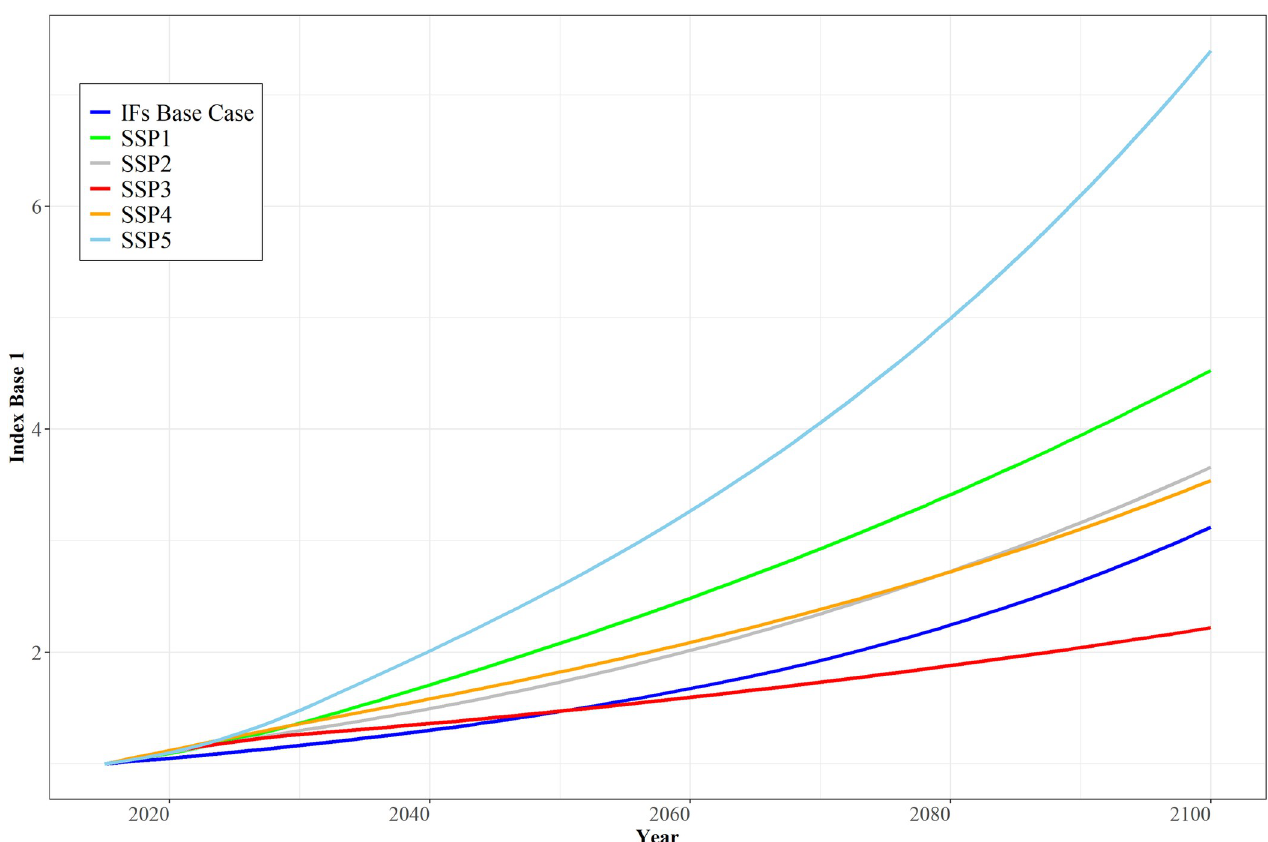
Fig 3. Global TFP projections from the OECD across SSPs and the Base Case projection from IFs. Notes: TFP scaling in the two sources differs and has been indexed to 1 to facilitate comparison. Country aggregation uses simple averages rather than GDP-weighting. SSPs 2 and 4 and the IFs Base Case are so close that the lines nearly overlap. Source: OECD projections courtesy of Rob Dellink and Jean Chaˆteau; IFs Version